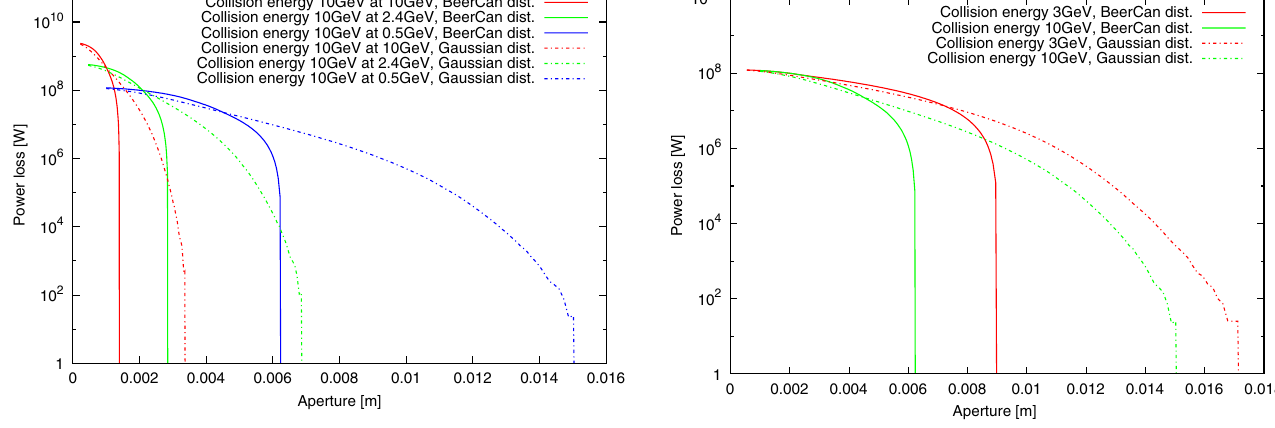
FIG. 17. (Color) Comparison of power loss at 0.5 GeV, between different collision energies of the electron beam, 10 and 3 GeV.